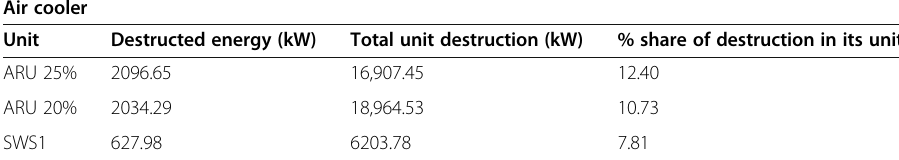
Table 12 Comparison between air coolers destructions in two units Air cooler Unit Destructed energy (kW)